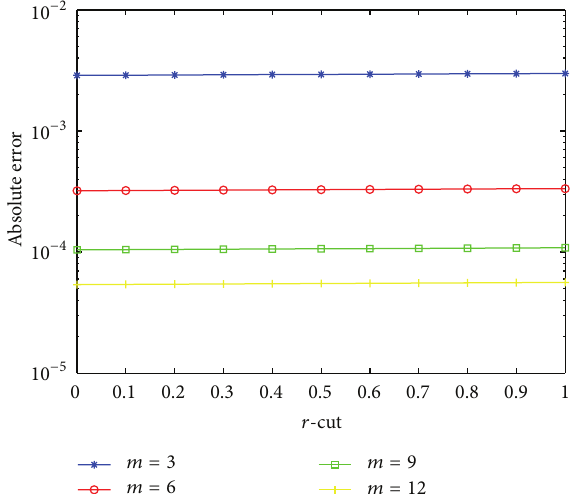
Figure 16: The absolute error for different 𝑚 of Example 62, 𝛼 = 0.85